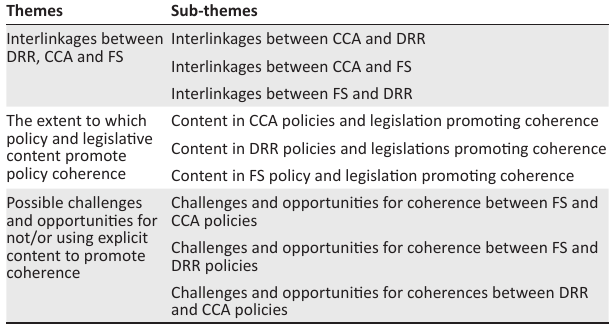
TABLE 2: Themes that emerged from the study.